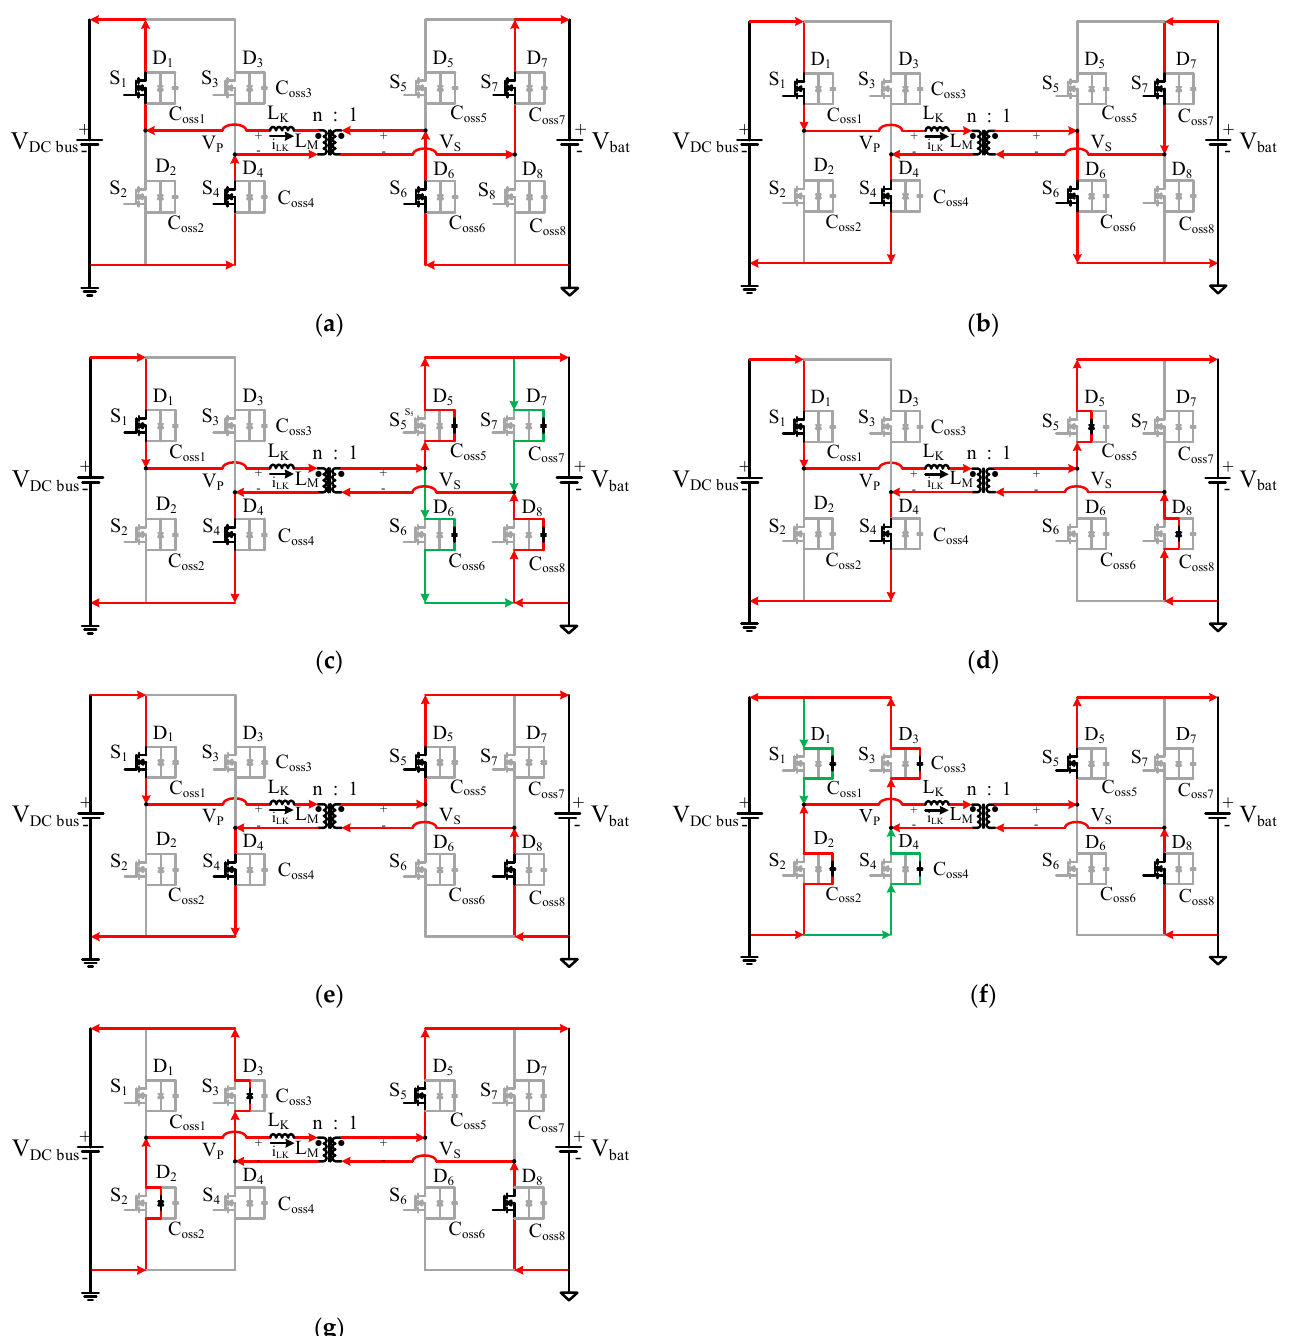
Figure 8. ( a – g ) The current flow path of the DAB converter in SPS control